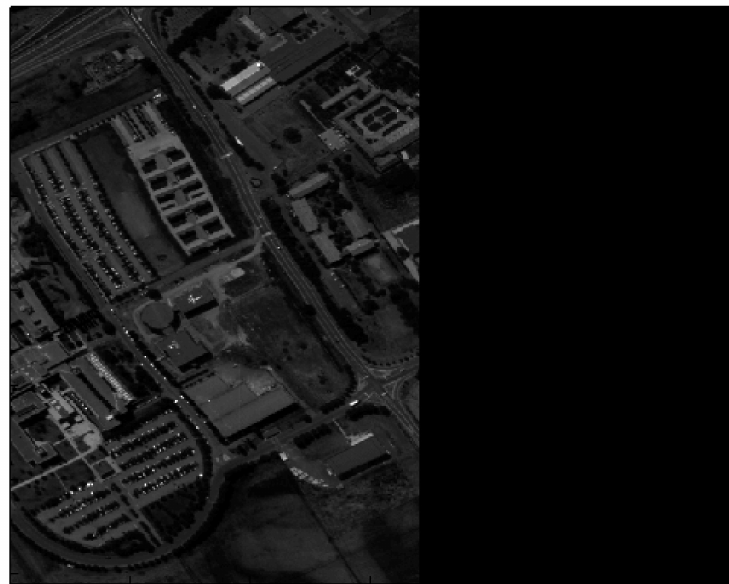
Figure 3. Sample band of Pavia University dataset.